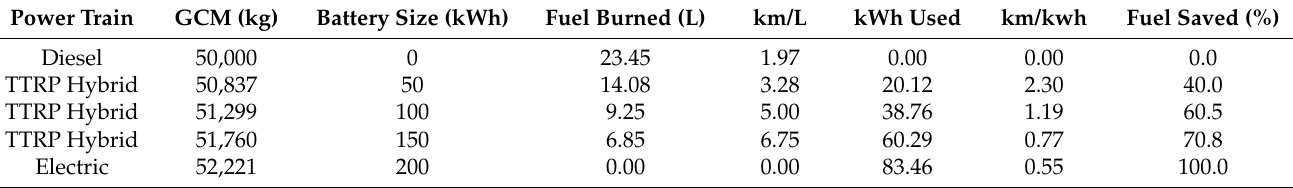
Table 7. Drive cycle 2 results.